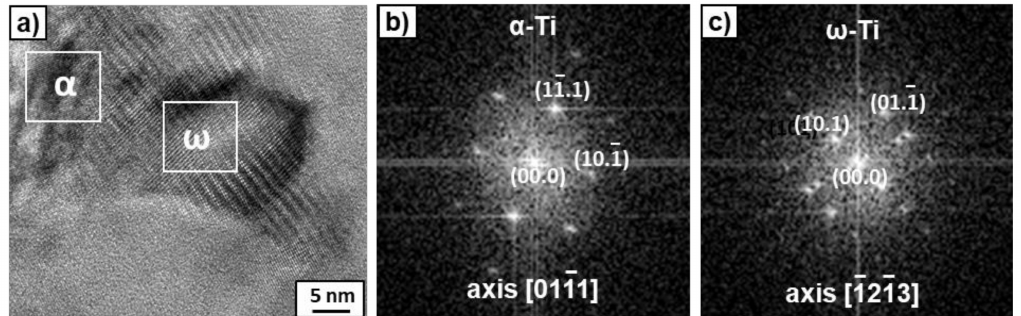
Figure 5. High-resolution TEM image ( a ) of the microstructure of the HPT-deformed Ti–3wt.% Nb alloy, pre-annealed at 600 ◦ C with Fast Fourier Transforms (FFT) obtained from the marked squares for the α -phase ( b ) and ω -phase ( c